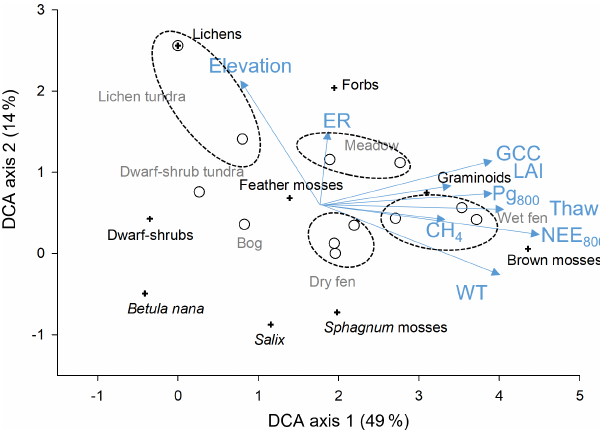
Figure 6. DCA ordination diagram based on species (species groups) data from the measurement collars in 2014. The explained variation in the species data is indicated for the axes. The scores are indicated for species groups (crosses), sample plots (small circles), and post-hoc fits of the supplementary variables (blue arrows). Land cover types of the sample plots are indicated in gray and the plots assigned to each LCT are circled (dashed